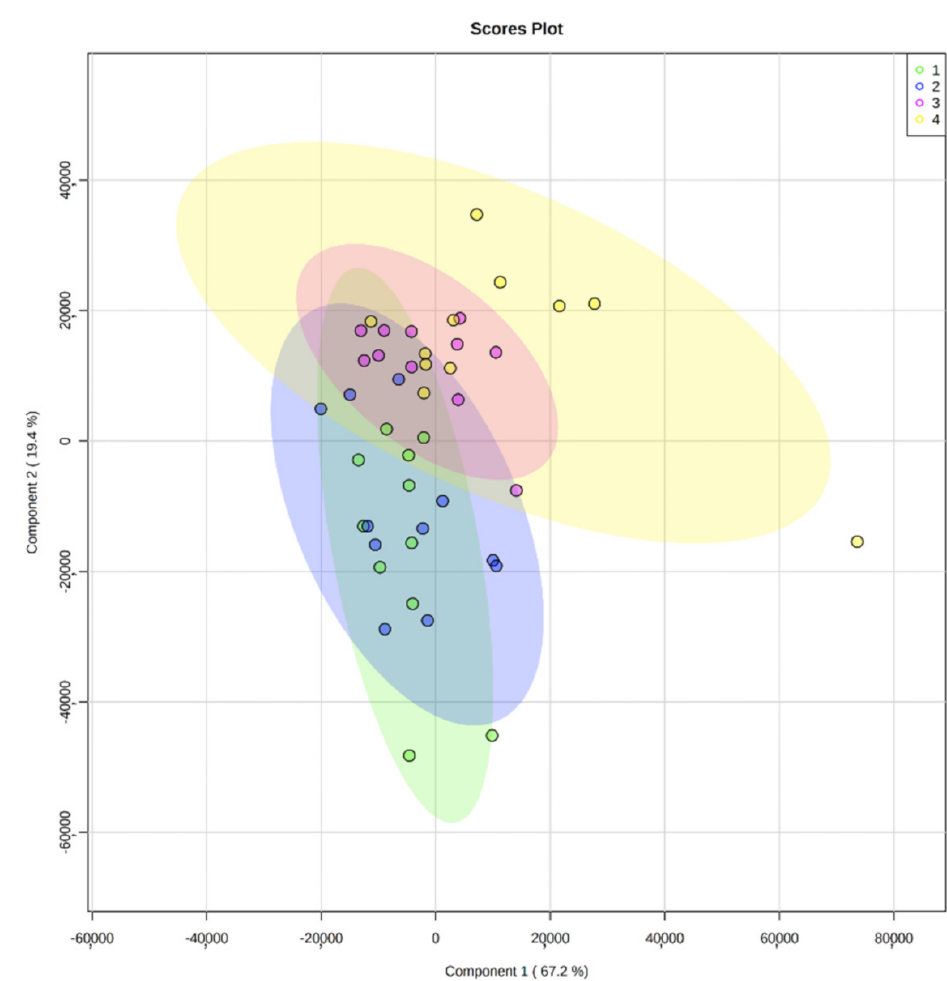
Figure 1. Partial least squares-discriminant analysis (PLS-DA) for human milk fat globule lipid concentrations in samples from a month one morning (green, 1), month one evening (blue, 2), month three morning (pink, 3), and month three evening (yellow, 4).